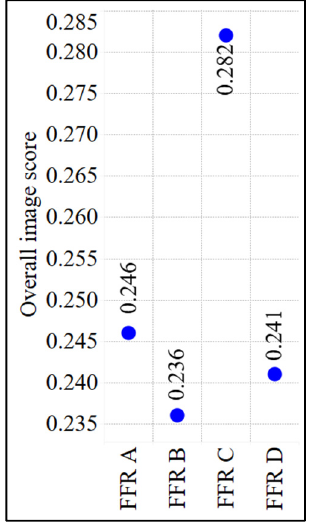
Figure 7. Overall image score of each FFR.